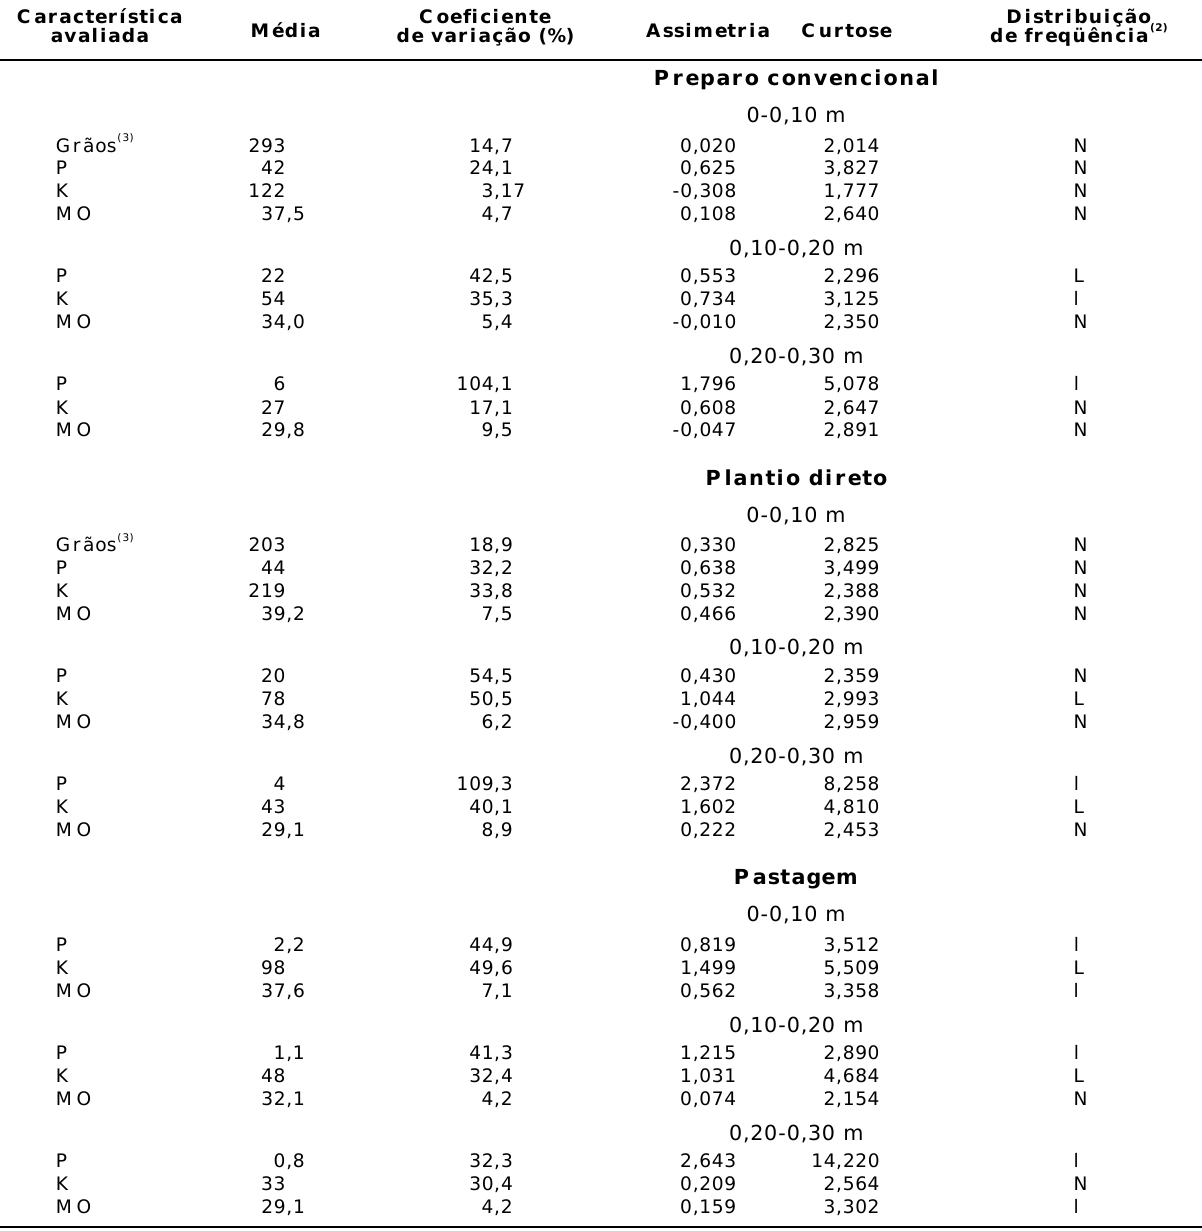
normal; e l = distribuição não definida entre as duas citadas, mas mais aproximada da lognormal. (3) Desconsiderar a profundidade, já que foram pesados em uma área de 1 m 2 , incluindo-se no quadro apenas para efeito